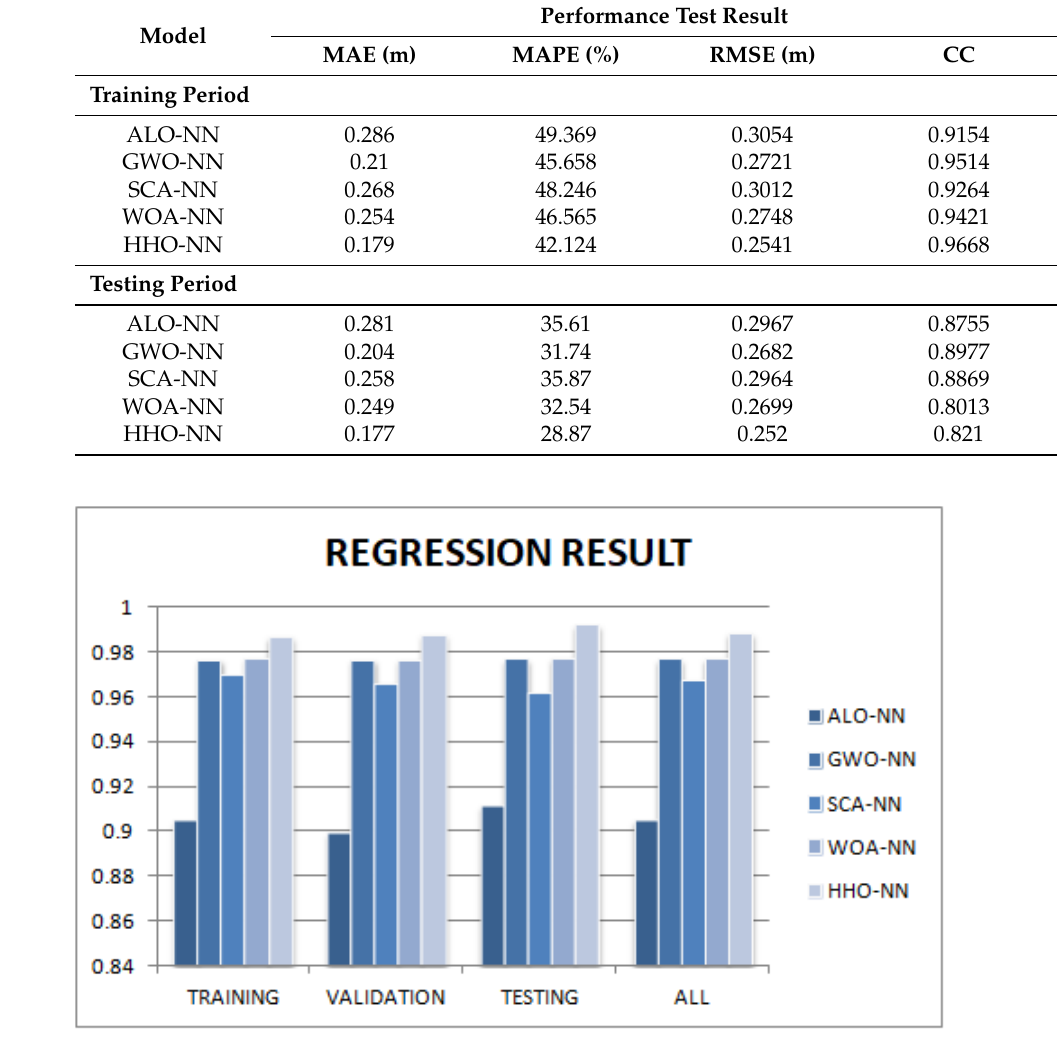
Figure 12. Regression